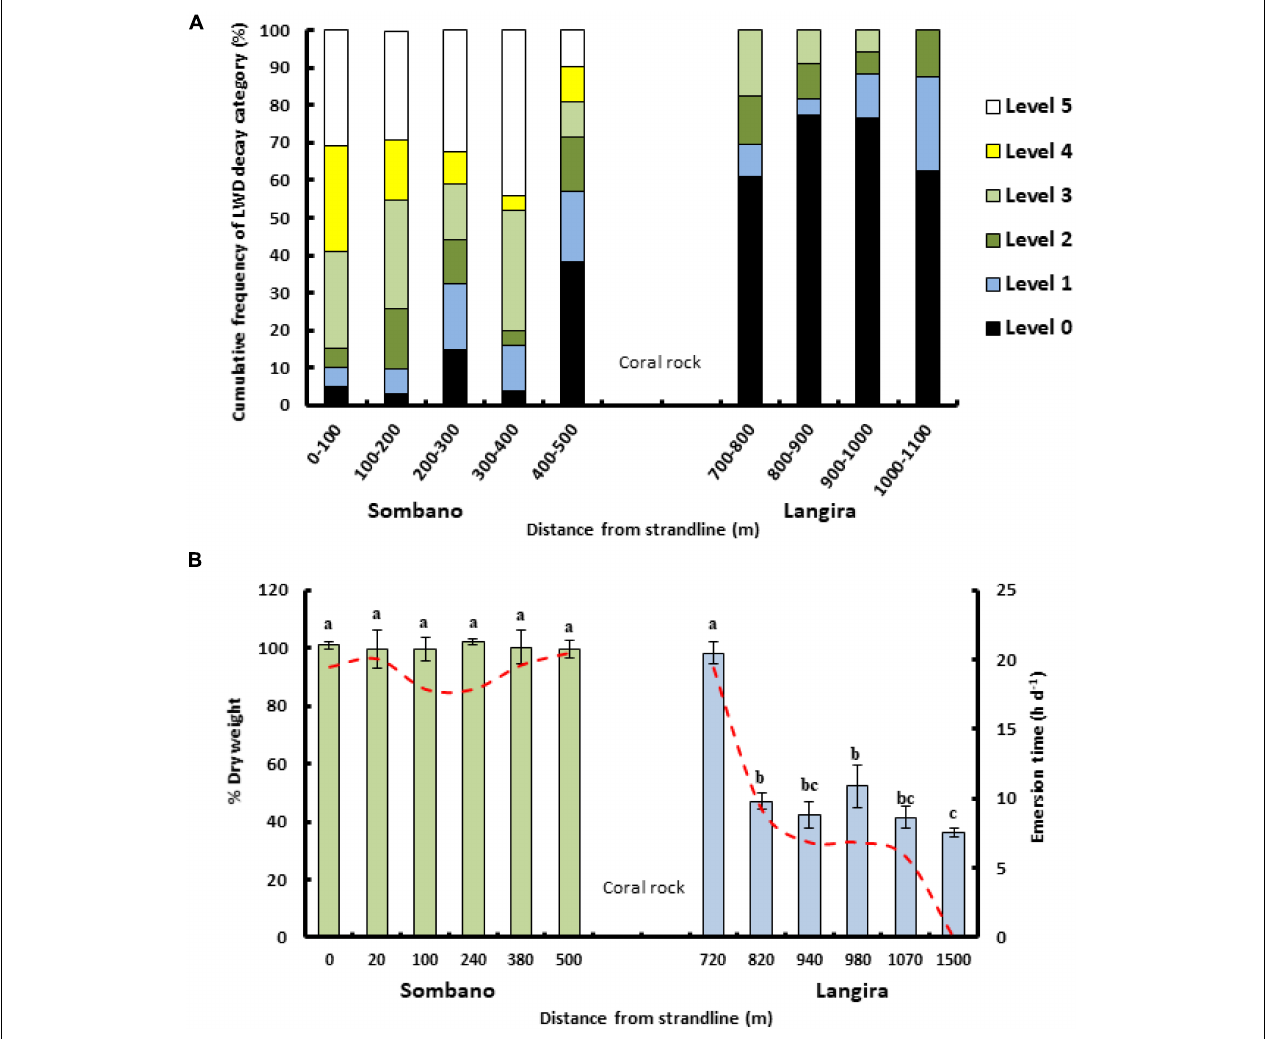
FIGURE 2 | Wood decay levels correspond to emersion time and increasing distance from the land. (A) The frequency (%) of fungal decay levels assigned to LWD ( n = 168) within Sombano and Langira. Decay levels correspond to the scale outlined in Table 1 , with level 0 being the least decayed and level 5 the most decayed. (B) The percentage dry-weight of experimental wooden panels (mean ± SE) exposed for 12 months within different areas of the Sombano and Langira forests. Emersion times are represented by dashed line. Wood loss is from teredinid activity. Letters above the bars = post hoc Tukey’s pairwise test